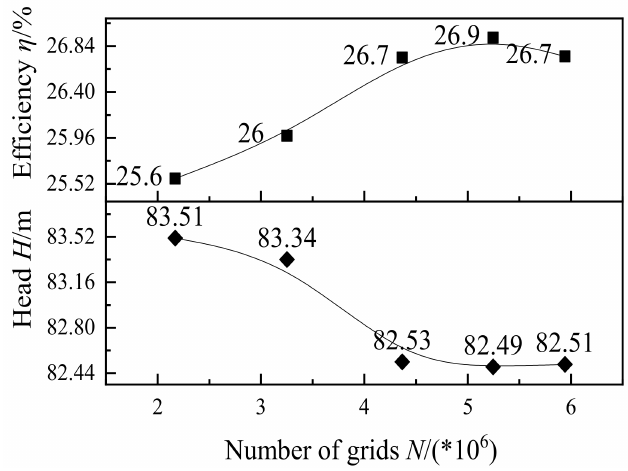
Figure 3. Grid independence